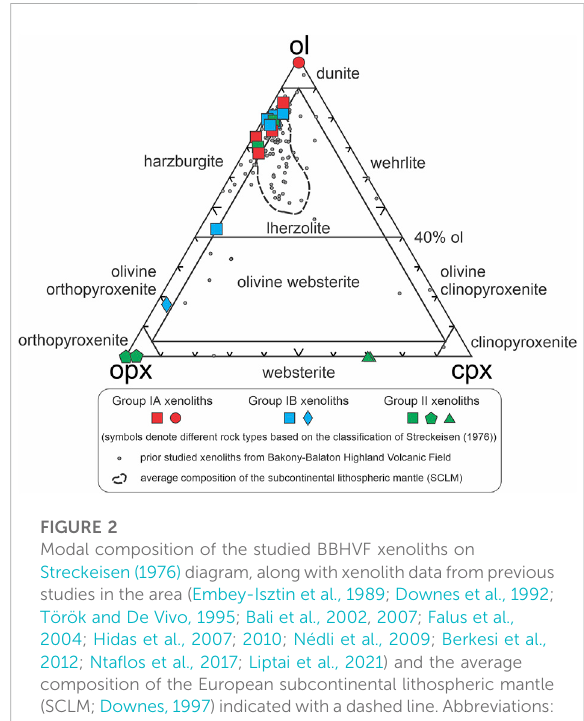
FIGURE 2 Modal composition of the studied BBHVF xenoliths on Streckeisen(1976)diagram,alongwithxenolithdatafromprevious studies in the area (Embey-Isztin et al., 1989; Downes et al., 1992; Török and De Vivo, 1995; Bali et al., 2002, 2007; Falus et al., 2004; Hidas et al., 2007; 2010; Nédli et al., 2009; Berkesi et al., 2012; Nta fl os et al., 2017; Liptai et al., 2021) and the average composition of the European subcontinental lithospheric mantle (SCLM; Downes, 1997) indicated with a dashed line. Abbreviations: ol - olivine; opx - orthopyroxene; cpx -